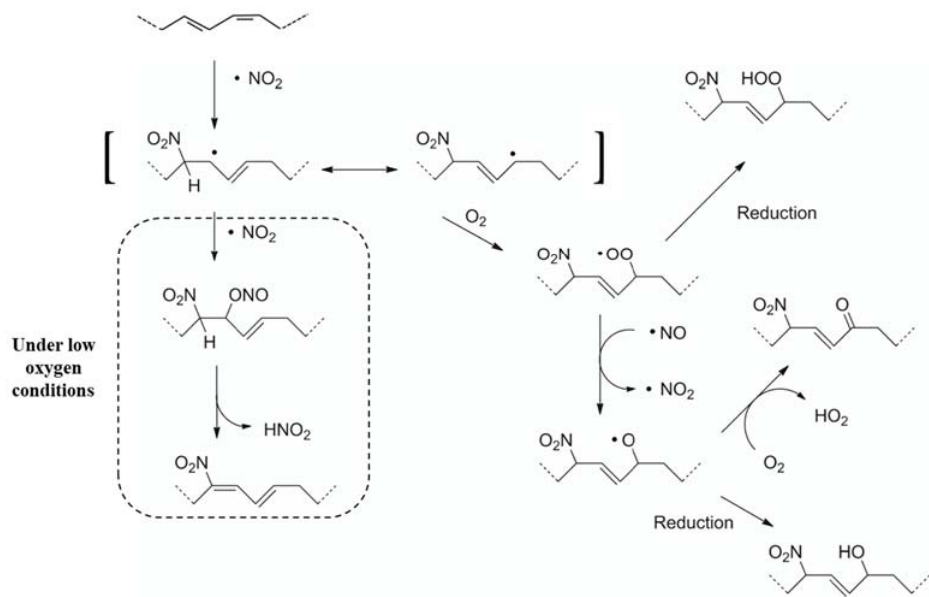
Figure 8. Formation of nitroalkenes under low and high oxygen conditions. Adapted with permission from Ref. [4]. Copyright 2011, F. J. Schopfer.